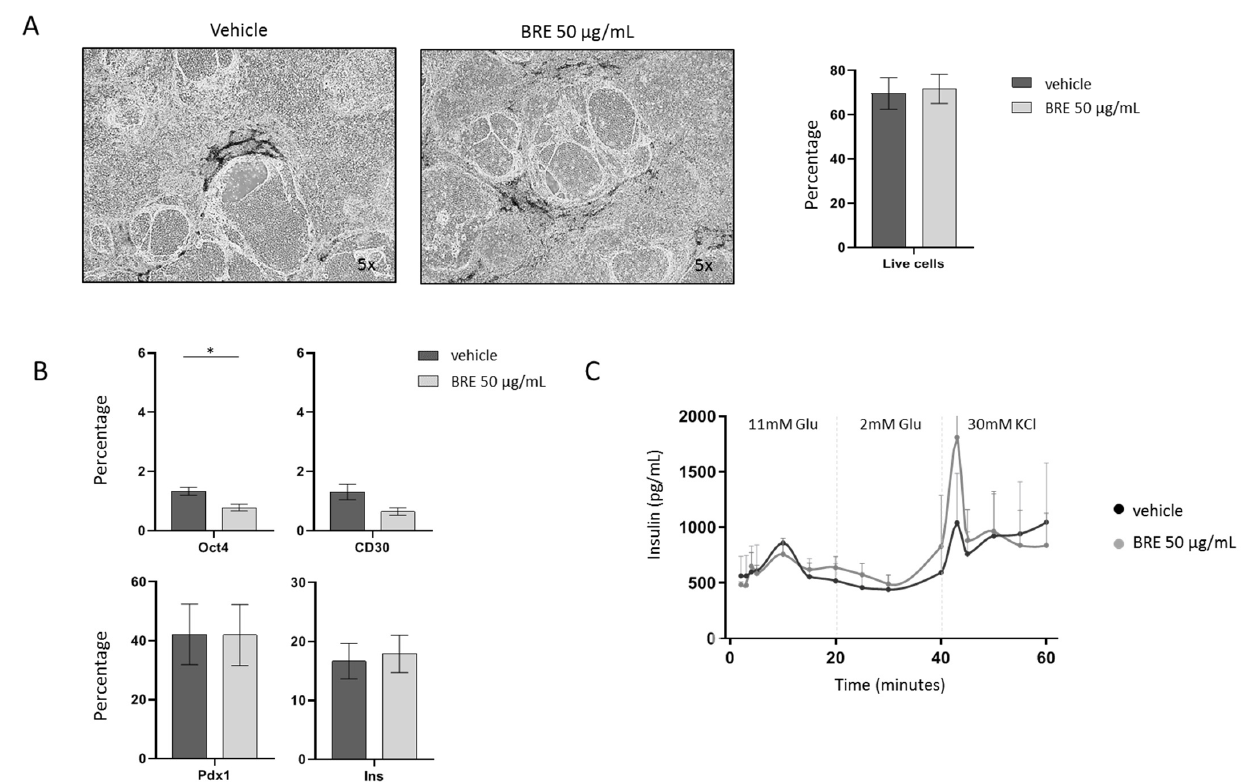
Figure 2. Effect of brentuximab vedotin on MODY8 iPSC-derived β cells. ( A ). Morphology of i β s treated with vehicle or 50 µg/mL BRE, magnification 5×, and percentage of live cells in flow cytometry ( n = 5). ( B ). Percentage of Oct4-, CD30-, Pdx1- and Insulin-positive cells gated on live cells in control (dark gray) and BRE (light gray)-treated cells ( n = 5, * = p < 0.05). ( C ). Insulin secretion profile in vehicle (black line) and BRE (gray line)-treated i β s in a dynamic perifusion assay ( n = 3).